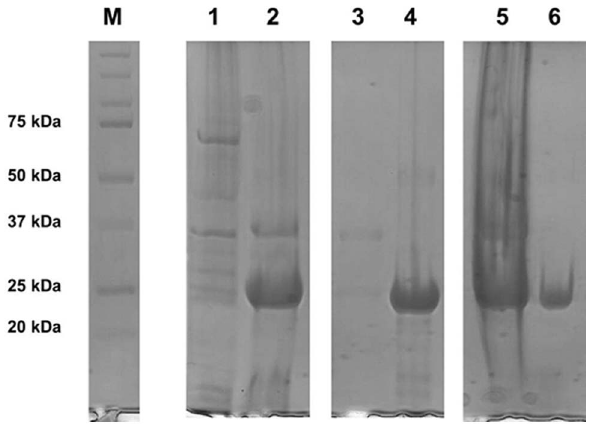
Figure 2. Different steps of rAL-1 renaturation from inclusion bodies . Protein samples were subjected to reducing 12% SDS-PAGE and stained with Coomassie Brilliant Blue. M: molecular mass markers; lane 1, supernatant of bacteria sonication; lane 2, pellet of cell sonication, containing inclusion bodies; lane 3, pellet of inclusion bodies solubilization; lane 4, supernatant of inclusion bodies solubili- zation; lane 5, pellet of recombinant protein refolding; lane 6, supernatant of recombinant protein refolding. A significant proportion of the expressed protein was soluble after refolding from inclusion